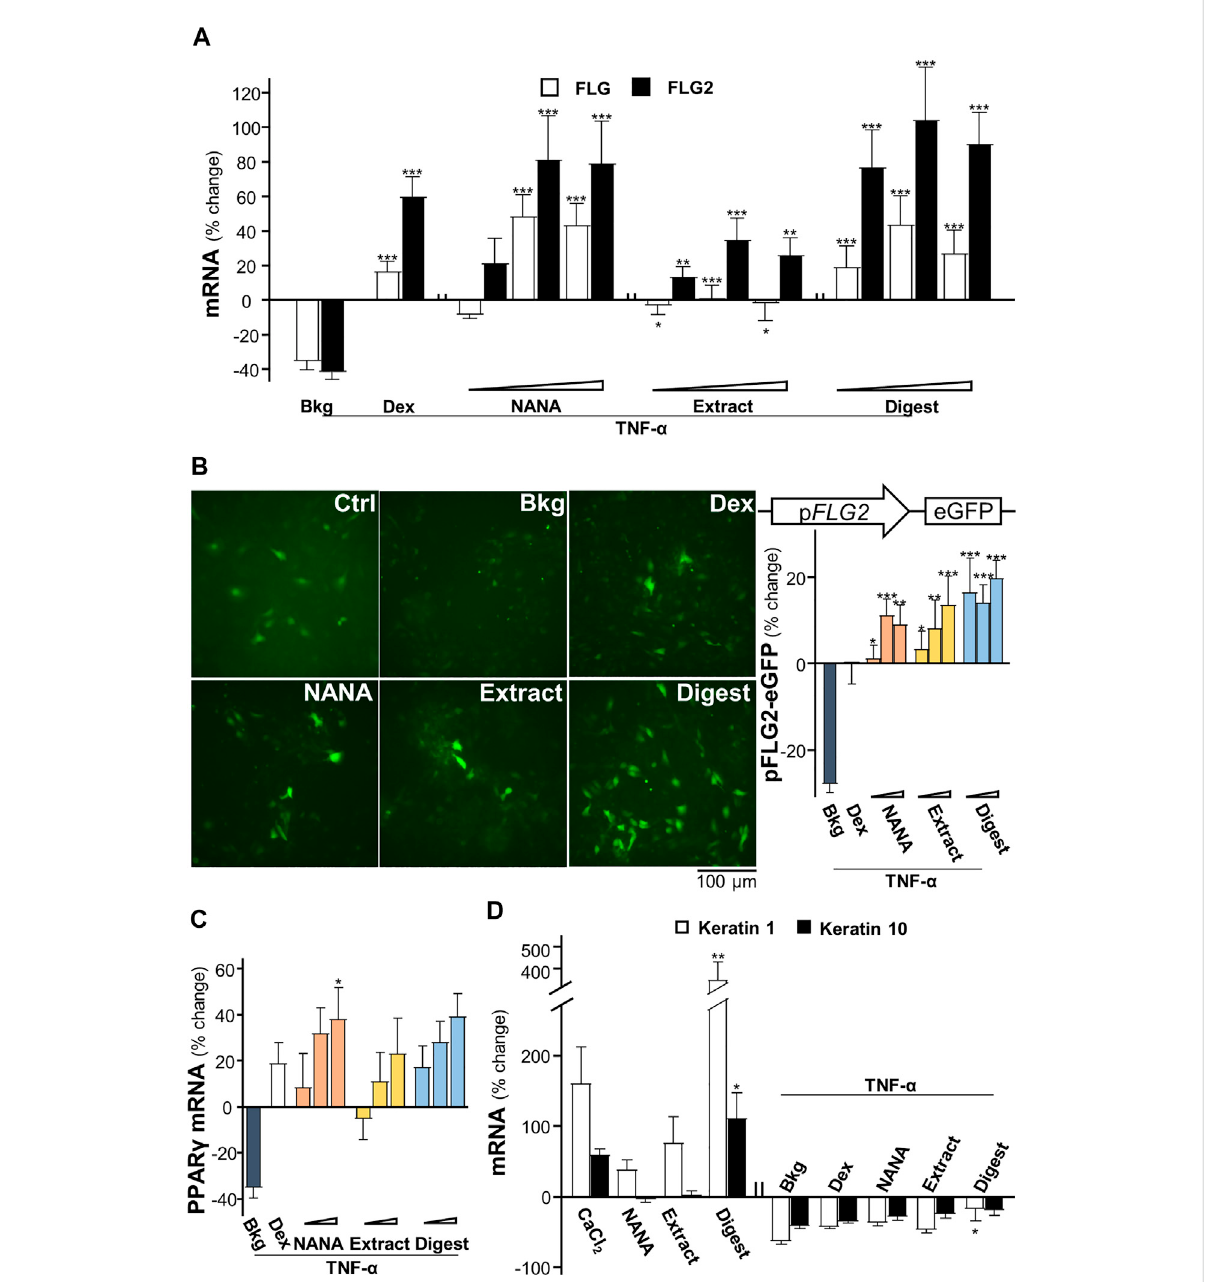
FIGURE 2 EBNrestorestheTNF- α -reducedexpressionsof fi laggrinand fi laggrin-2viainductionofmoisturizationanddifferentiation. (A) ThemRNAlevels of fi laggrinand fi laggrin-2inculturedHaCaTkeratinocytesafter2-hco-treatmentofTNF- α (20 ng/mL)andEBNpreparationareshown.NANA(0.05, 0.1, 1 mM), and EBN extract or digest (1, 10, 100 μ g/mL) were applied, as indicated. Dexamethasone at 10 nM was a positive control. (B) The pFLG2- eGFP plasmid, composed of the vector pEGFP-N1 containing a fi laggrin-2 promoter, was transfected into keratinocytes for 24-h, followed by seeding at 1 × 10 5 cells/mL in a 96-well black clear bottom plate. A 24-h pre-incubation of EBN, followed by another 24-h stimulation of TNF- α (100 ng/mL).Thedoseswereasin(A).Representative fl uorescenceimagesaredisplayed,withdosesof1 mMand100 μ g/mLselectedforNANAand EBN extract or digest, respectively (left panel). The GFP activity of each well was normalized to total protein (right panel). (C) The mRNA levels of PPAR γ inculturedHaCaTkeratinocytesafter2-hco-treatmentofTNF- α (20 ng/mL)andEBNpreparation(rightpanel),areshown.Thedoseswereas in (A). (D) The mRNA levels of keratin 1 and keratin 10 in cultured HaCaT keratinocytes are shown. NANA (1 mM), EBN extract and digest (both at 100 μ g/mL) were applied for 24-h, or simultaneously with TNF- α (20 ng/mL) for 2-h. CaCl 2 (0.16 mM) and dexamethasone (10 nM) were positive controls. Values are expressed as the percentage of change relative to normalized basal expression set at 0%, in mean ± SEM, n = 6. Statistically signi fi cantresultsaremarkedwith* p < 0.05,** p < 0.01and*** p < 0.001againstthecontrol,ortheTNF- α -treatedgroup,dependingonexperiments performed without or with TNF- α